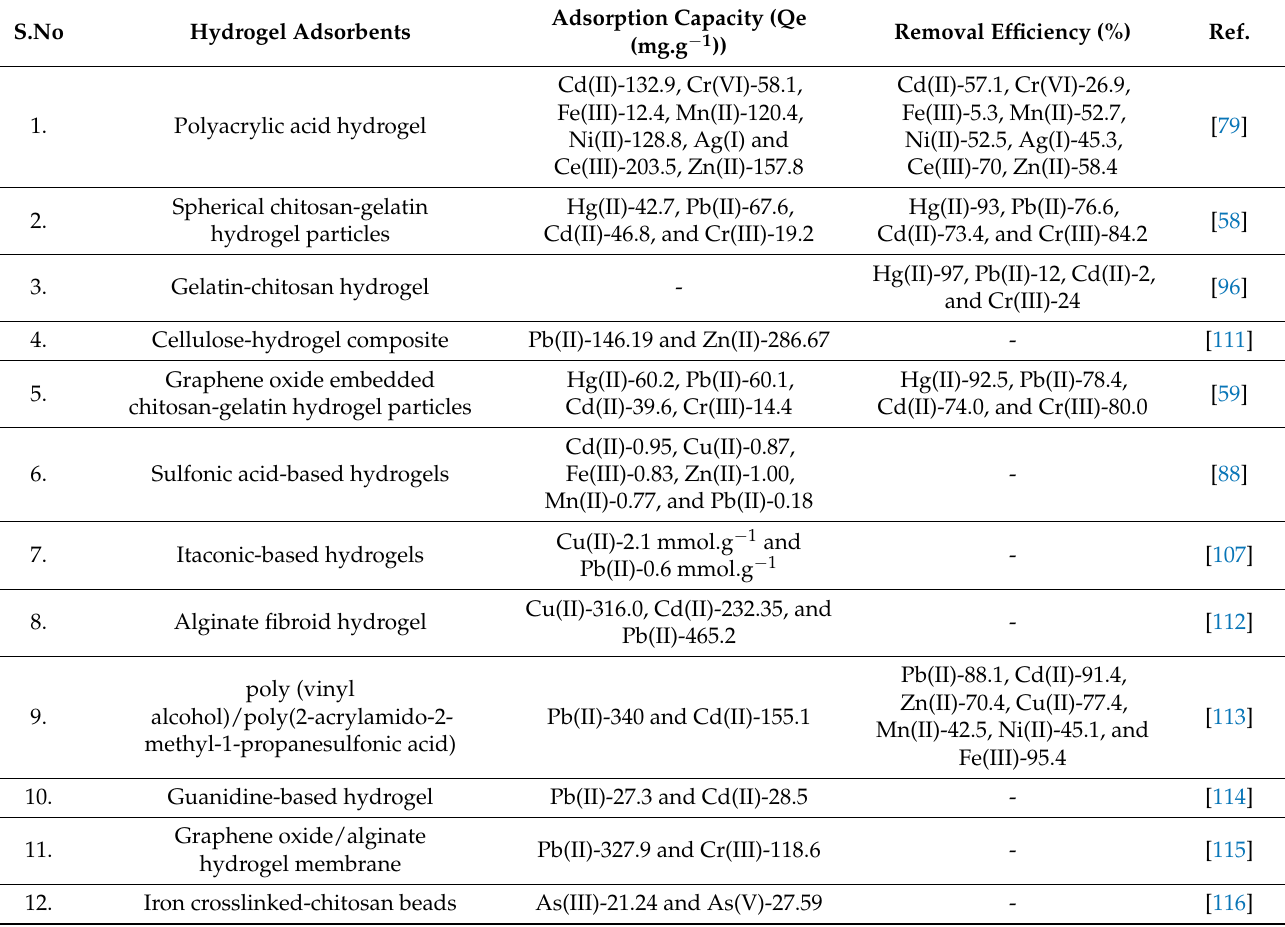
Table 2. Adsorption capacity and removal efficiency of heavy metal ions using different adsorbents in multiple metal ion